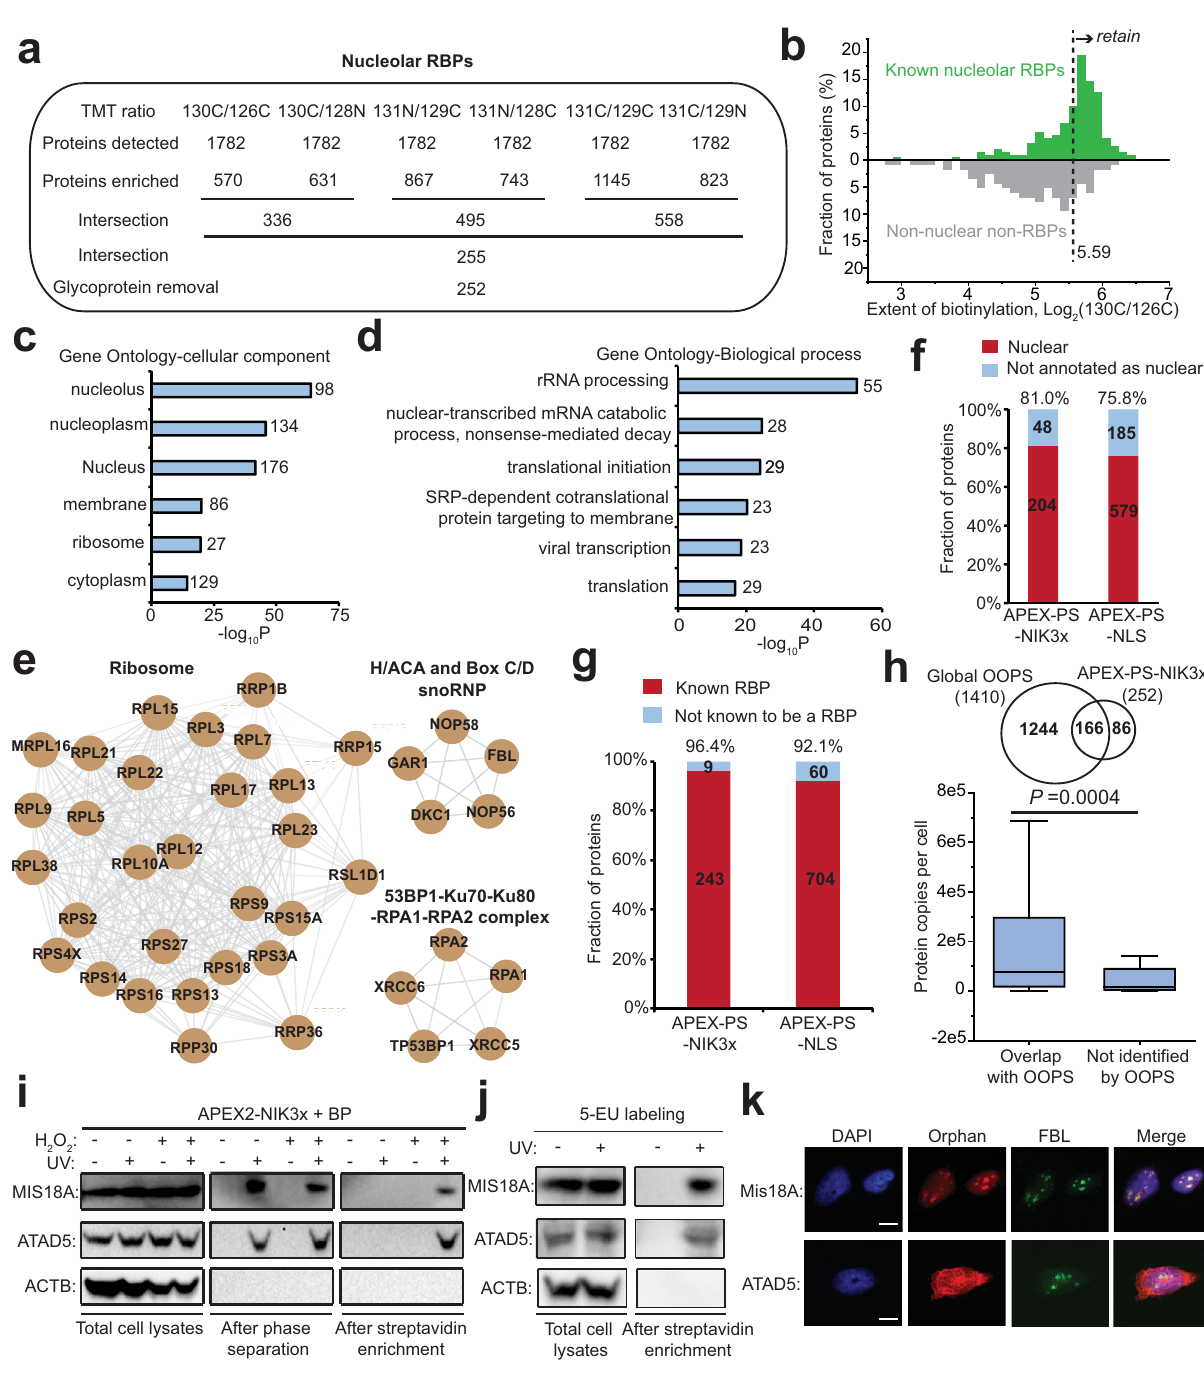
Fig. 4 Proteomic pro fi ling of nucleolar RBPs by APEX-PS. a Numbers of proteins remaining after each step of fi ltering the mass spectrometric data using the “ pairwise ROC strategy ” . The fi nal nucleolar RBPome has 252 proteins (Supplementary Data 3). b Sample histogram showing how the cutoff for 130 C/ 126C TMT ratio was applied. c GO cellular component analysis of nucleolar RBPs identi fi ed by APEX-PS. d GO biological process analysis of nucleolar RBPs identi fi ed by APEX-PS. e Molecular complexes enriched in nucleolar RBPome. Gray lines indicate protein-protein interactions annotated by the STRING database. f Nuclear speci fi city of nucleolar RBPome. g RBP speci fi city of nucleolar dataset. See Supplementary Data 3 for details. h Overlap with global RBP dataset obtained by OOPS 26 . Bottom: Comparison of protein abundance for RBPs identi fi ed by both methods to those identi fi ed by APEX-PS only. Box limits represent 25th percentiles, medians, and 75th percentiles. Statistical analysis was performed with one-sided Wilcoxon rank sum test. i Validation of MIS18A and ATAD5 as novel nucleolar RBPs by UV crosslinking APEX-PS. j Validation of the RNA binding of MIS18A and ATAD5 by metabolic labeling of RNA by 5-EU and UV crosslinking. k Confocal imaging of endogenous MIS18A and ATAD5. Anti-FBL stains nucleolus and DAPI stains nuclei. Scale bars, 10 μ